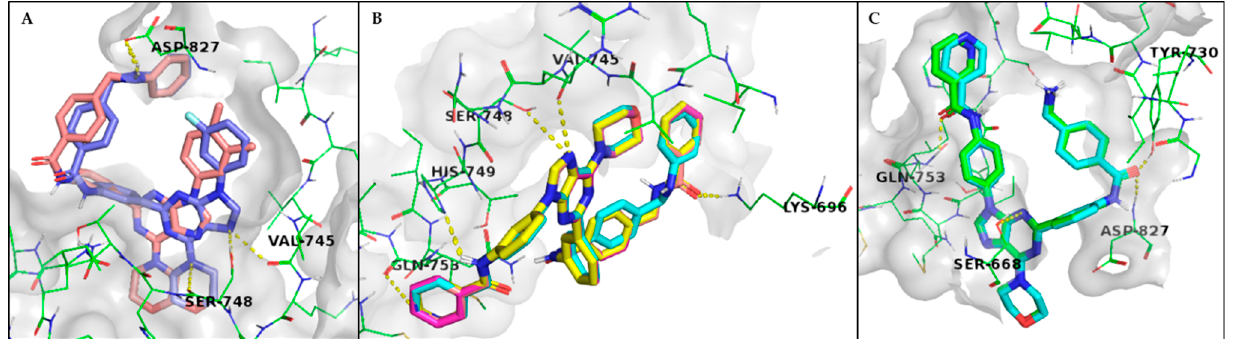
Figure 9. Interaction-binding mode of docked ligands in the active site of PI3K α . Overlay of ligands 7d and 9d ( A ); ligands 15d , 15e , 17e , and 19e ( B ); ligands 16a and 18a ( C ).